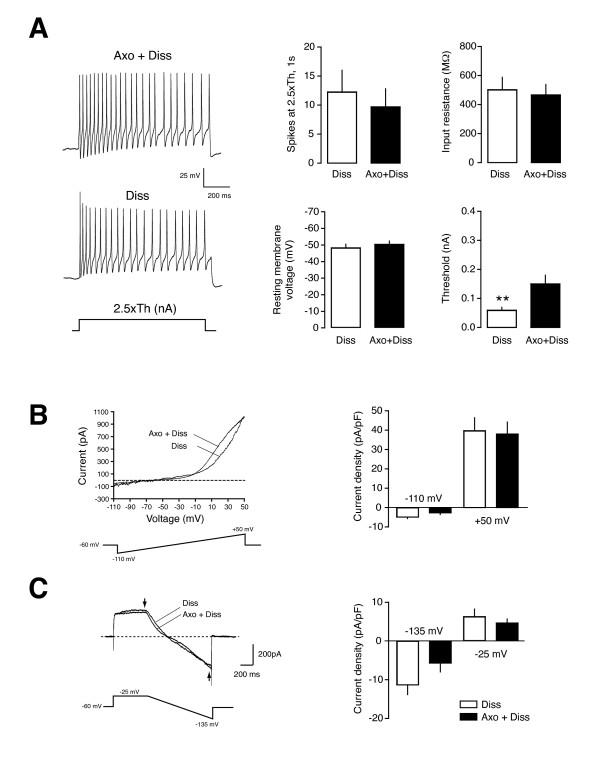
In vitro and axotomy produces similar changes than in vivo axotomy. A. Acute dissociation of DRG sensory neurons produces similar hyperexcitability in previously injured or non-injured neurons. Left: Examples of spikes fired by a neuron axotomized in the animal and later dissociated and another cell only acutely dissociated. Right: Quantification of number of spikes fired, input resistance, resting membrane potential and action potential threshold. **p < 0.01 t-test Dissociated (Diss; n = 16) vs. Axotomized+dissociated (Axo+Diss; n = 15) cells. B. Effects of in vitro axotomy in total whole-cell currents. Currents elicited by a voltage ramp (-110 to +50 mV) in Diss. and Diss+Axo neurons (n = 7 for each group) in the presence of 2 μM TTX. Quantification did not show significant differences in currents at -110 or +50 mV. C. Examples of recordings in Diss. and Diss+Axo neurons using a protocol to minimize activation of voltage-gated transient K+ outward currents. Quantification of currents at the end of the pulse at -35 mV (arrow) and at the end of the ramp (-135 mV; arrow) did not show significant differences among groups.